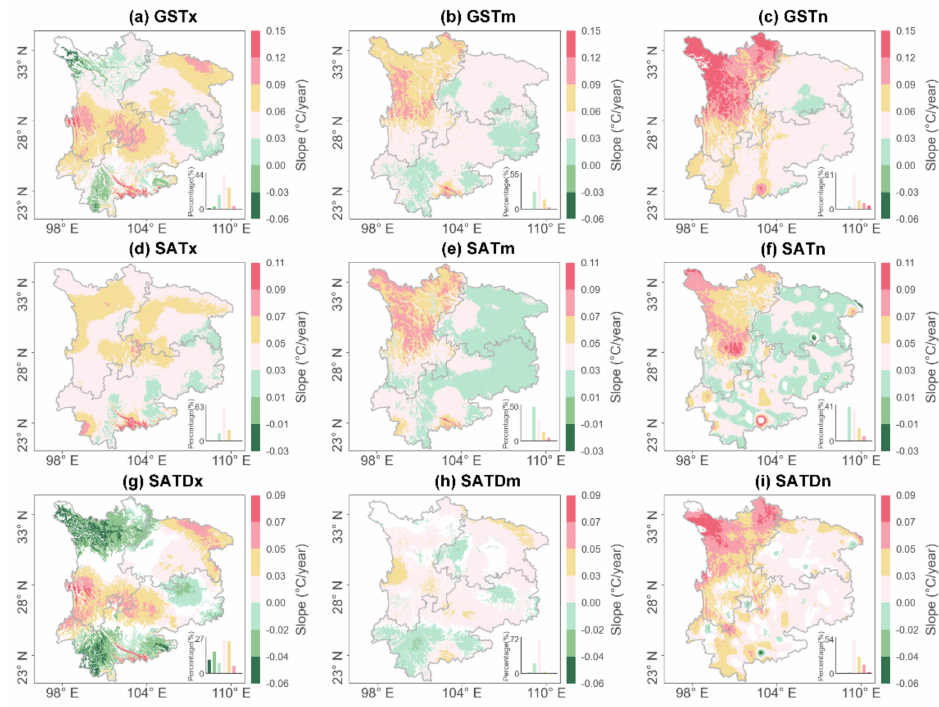
Figure 6. Significant variation rate of annual averaged ( a – c ) GST-, ( d – f ) SAT-, and ( g – i ) SATD-related indexes for each pixel from 1980 to 2019 in Southwest China. (Significance test by MMK trend method at the 0.05 confidence level). The different colors represent the variation rate and the histograms represent the significant ( p ≤ 0.05) percentage of the classified pixel. Table 6. Percentage of significant ( p ≤ 0.05) increasing/decreasing pixels of annual and seasonal averaged GST-, SAT-, and SATD-related indexes in Southwest China from 1980 to 2019. Annual Spring Summer Autumn